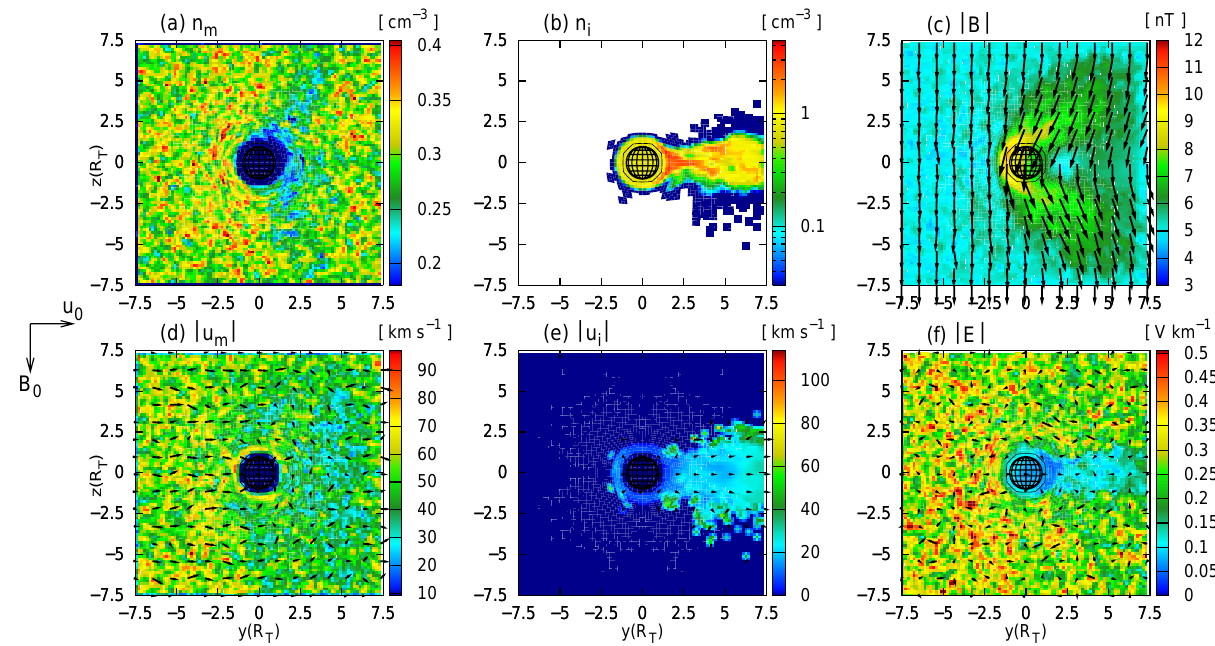
Fig. 17. Titan’s plasma environment at 00:00 Saturnian local time. The figure displays a cut through the obstacle’s polar plane which coincides with the (y,z) plane of the coordinate system. The figure displays (a) the magnetospheric ion density, (b) the ionospheric nitrogen density, (c) the magnetic field strength, (c) the magnetospheric ion velocity, (e) the ionospheric ion velocity and (f) the electric field. The magnetic draping pattern is not as pronounced as in the 06:00 LT and the 18:00 LT scenario. On the one hand, the magnetic lobes are less confined to the immediate vicinity of Titan; on the other hand, the peak magnetic field strengths in the lobe regions as well as in the pile-up region at Titan’s ramside are significantly weaker than in the simulations assuming the upstream plasma flow to be super-Alfv´enic. Moreover, the area of reduced magnetic field strength between the two lobes, being characteristic for both the 06:00 LT and the 18:00 LT case, has almost vanished. Compared to the other simulations presented in this work, the characteristic time scale for the formation of the magnetic field pattern is significantly smaller, allowing the field lines to pass the obstacle in the direction perpendicular to the cutting plane. The ionospheric tail’s extension perpendicular to the flow direction is larger than in the 06:00 LT and the 18:00 LT simulation. In the downstream region, the electric field strength and the magnetospheric plasma parameters exhibit only a minor